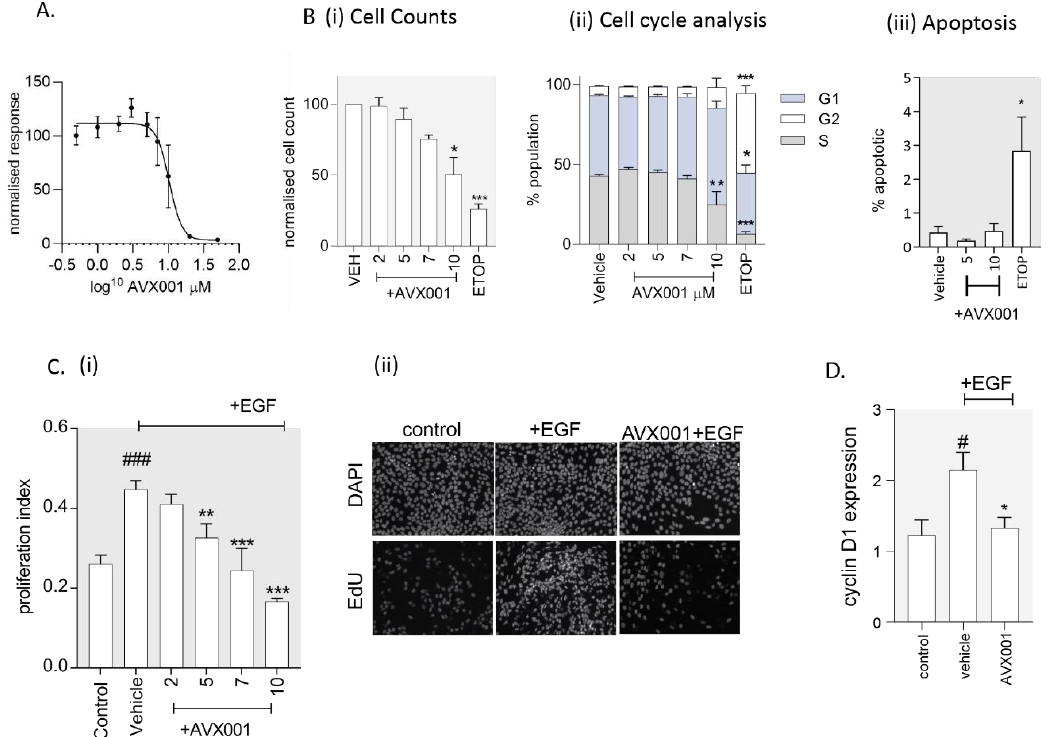
Figure 3. AVX001 inhibited proliferation in HaCaT monolayers. ( A ) Cell viability was measured using the resazurin assay in proliferating HaCaT treated with AVX001 for 24 h at the concentrations indicated. Measurements were normalized to the vehicle-treated control, and the mean ± SEM for three replicates is shown. ( B ) Automated microscopy and analysis of fluorescently labeled DNA, incorporated EdU, and caspase-3/7 activity was used to quantify ( i ) cell number, ( ii ) cell cycle distribution, and ( iii ) apoptosis in proliferating HaCaT treated with AVX001 for 24 h at the concentrations indicated. Data are mean ± SEM for ≥4 replicates. ( C ) ( i ) The proportion of cells in S-phase of the cell cycle (proliferation index) was determined by counting the total and EdU-positive nuclei in proliferating HaCaT pre-incubated with vehicle or AVX001 and stimulated with EGF (30ng/mL, 24 h). Data are the mean ± SEM for three replicates from a representative experiment, repeated twice. ( ii ) Representative images showing 4′,6 -diamidino-2-phenylindole (DAPI)-stained nuclei (DAPI) and fluorescently labelled EdU (EdU) for unstimulated HaCaT (control), and HaCaT stimulated with EGF (30 ng/mL, 24 h) in the absence (+EGF) or presence of 7 µM AVX001 (AVX001+EGF). ( D ) The relative expression of cyclin D1 measured by quantitative PCR in proliferating HaCaT pre-treated with AVX001 and stimulated with EGF (30 ng/mL, 4h). Data were normalized to the unstimulated control (control) and are the mean ± SEM from six replicates. Statistical significance was calculated by one- way ANOVA with Dunnett’s post -analysis, or, for normalized data, the Kruskal –Wallis test with Dunn’s post -analysis; # p < 0.05, ## p < 0.01, or ### p < 0.005 versus unstimulated control and * p < 0.05, ** p < 0.01, *** p < 0.005 versus vehicle-treated control. Treatment with EGF for 24 h did not significantly impact cell viability (not shown), but rather led to an increase in the proportion of cells in S-phase of the cell cycle (proliferation index), which was inhibited by AVX001 (≥5 μM) (Figure 3C). Progression of the cell cycle from G1 to S -phase in response to growth factors is typically associated with increased levels of cyclin D1 [65]. Following 4 h of EGF treatment, cyclin D1 transcript levels were increased approximately twofold in HaCaT, and